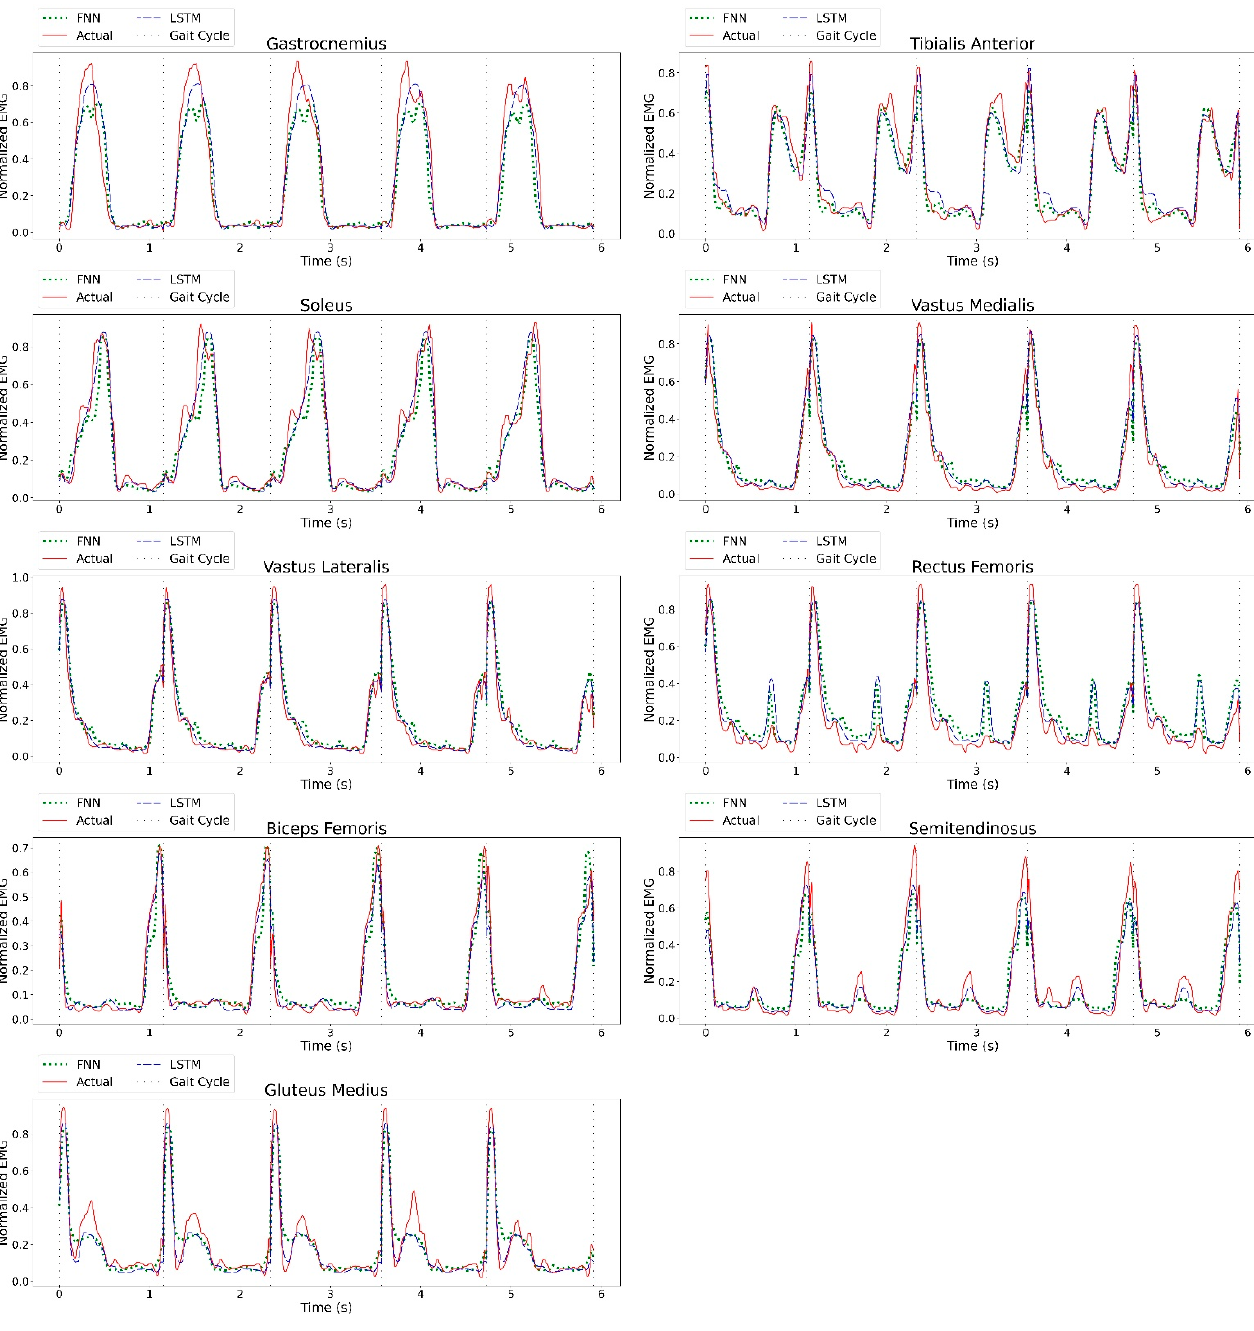
Figure A2. A plot of actual vs. predicted muscle activities of the test data (Sample B).